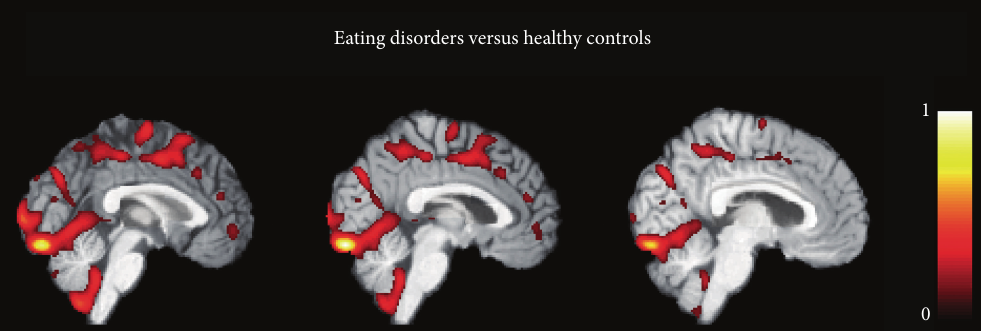
Figure 4: Voxel-based pattern distribution map of brain structural differences between ED patients and healthy controls (sagittal view, threshold = 50%). Voxel-based pattern distribution (normalized to a range between 0 and 1) is expressed according to the color scale and superimposed on a standard stereotactic brain for spatial localization.